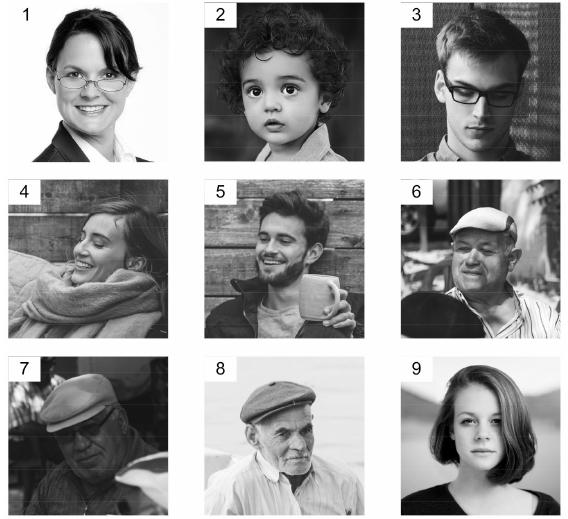
Figure 3. Face images saved (source: https://pixabay.com/pl, accessed on 17 February 2021). In the experiments, the identification numbers 1, 2, . . . , 9 were assigned to the images.